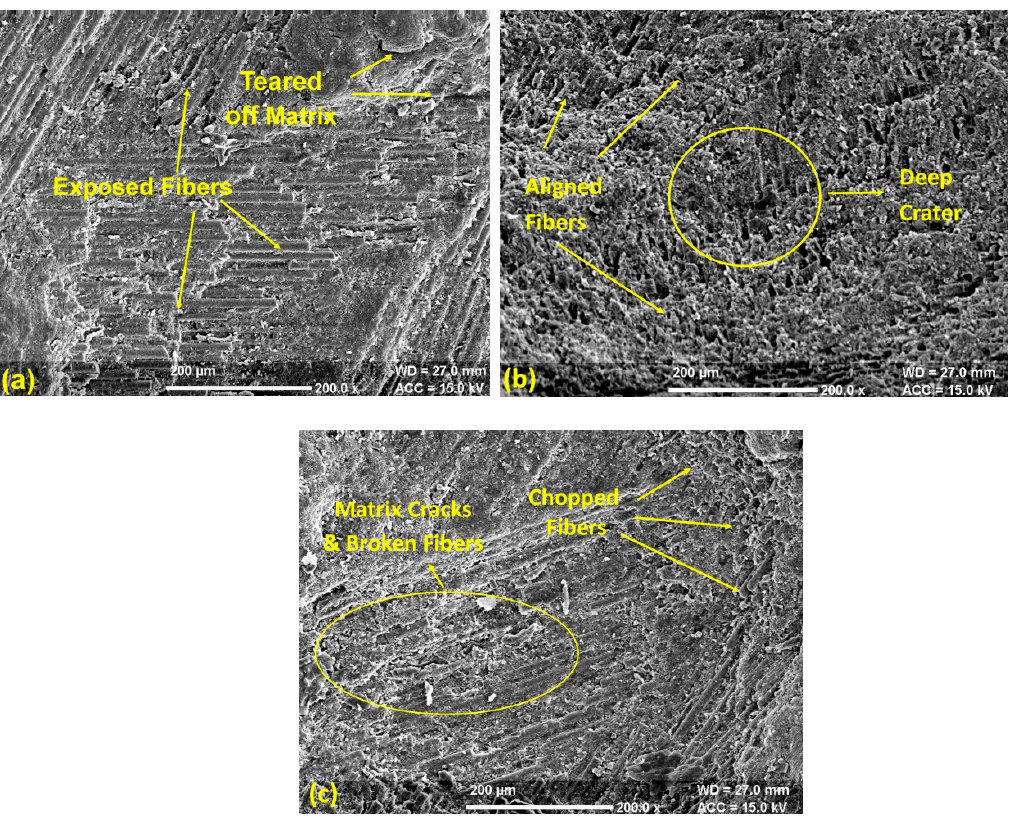
Figure 9. ( a ) SEM of erosion at a 30 ◦ impingement angle, ( b ) SEM of erosion at a 60 ◦ impingement angle and ( c ) SEM of erosion at a 30 º impingement angle.